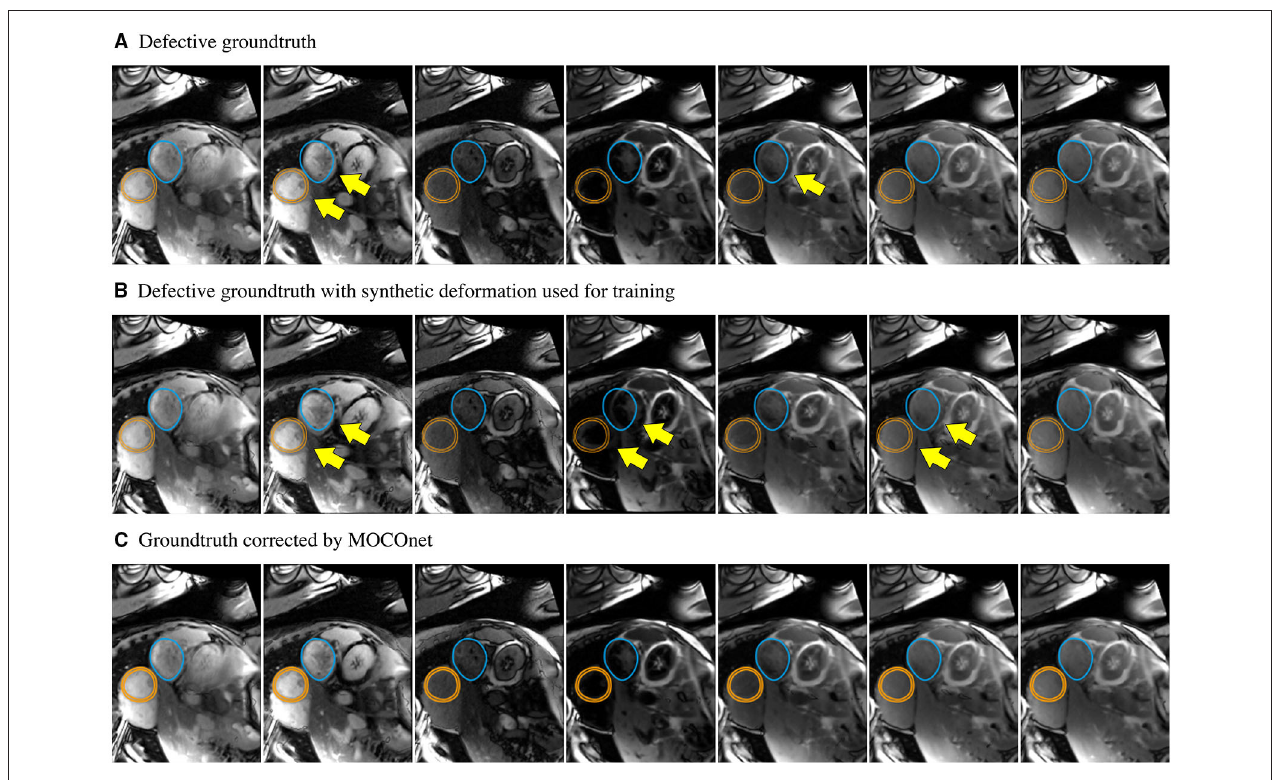
FIGURE 5 | Robustness of the proposed motion correction convolutional neural network (MOCOnet) for myocardial ShMOLLI T1 mapping from a noisy training sample. (A) Training sample falsely considered free of motion (1 in 1,536) as manually depicted with unaligned myocardium (orange) and stomach (blue) with yellow arrows throughout the inversion recovery-weighted images. (B) Applied deformation to the training sample used for training. (C) Sample corrected by MOCOnet after training demonstrating the successful learning of the general rule without replicating the